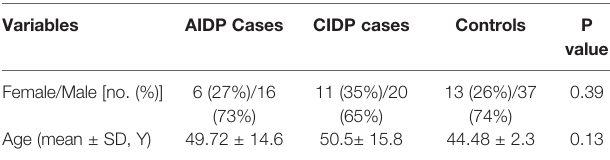
TABLE 2 | General demographic and clinical information of cases and